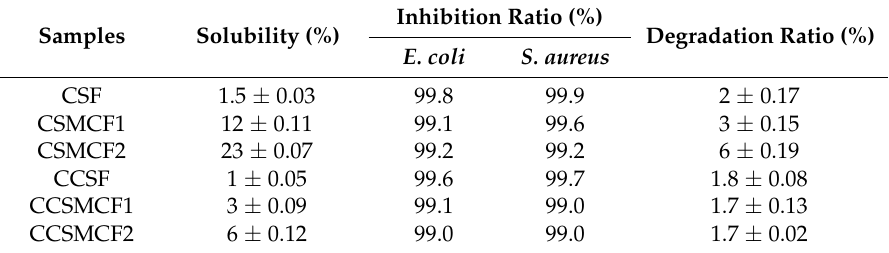
Table 4. Solubility, degradation ratio, and antibacterial properties of the obtained films.